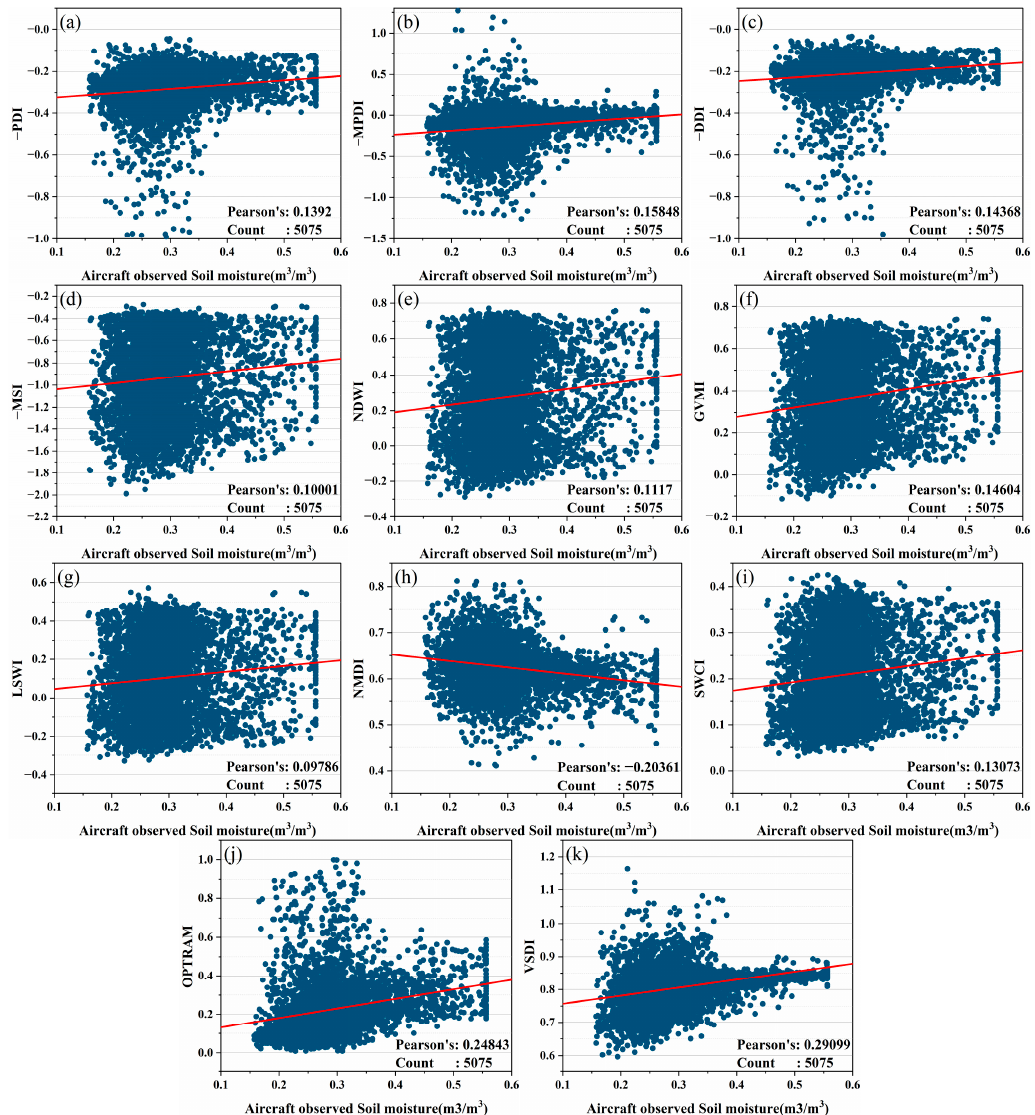
Figure 8. ( a – k ) Scatter plot between aircraft SM and Sentinel MSI-derived SM indexes on 20 June 2016 during the SMAPVEX16 Manitoba experiment.